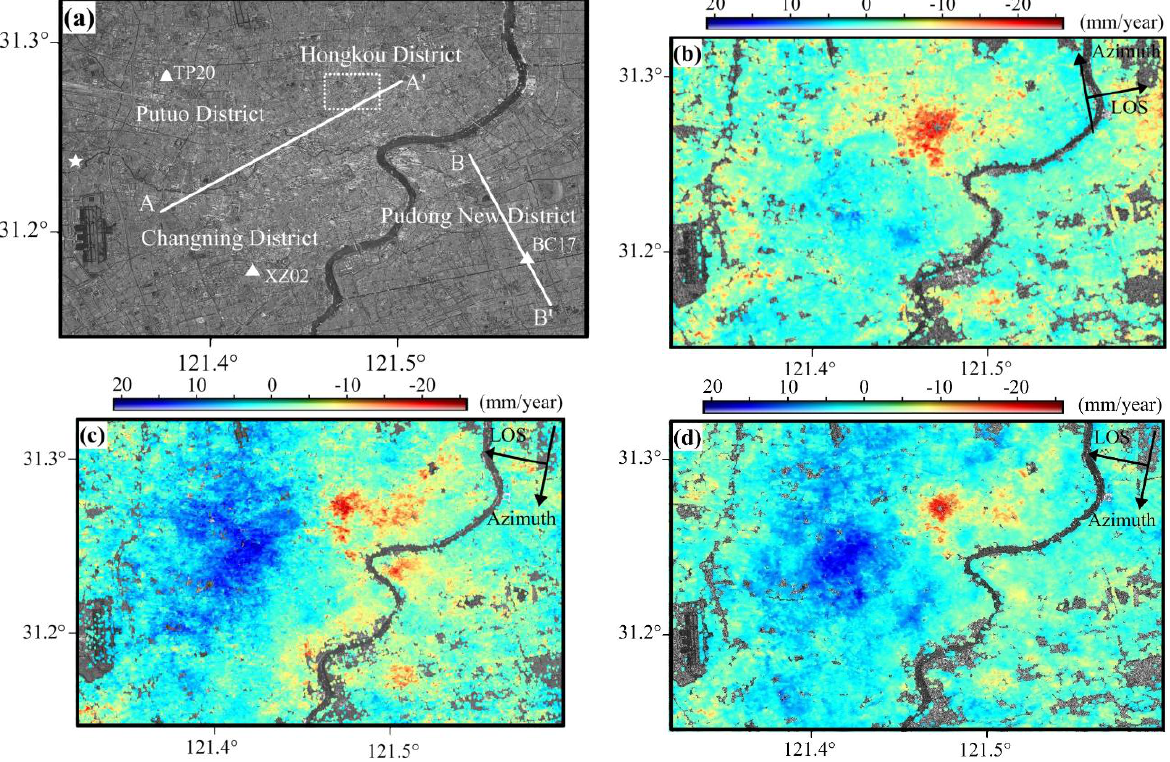
Figure 4. The SAR amplitude image and the VDRs in the study area derived through the TCPInSAR processing. ( a ) shows the SAR amplitude image with annotation of the placenames (Hongkou District, Pudong New District, Putuo District, and Changning District), three GPS sites (TP20, XZ20, and BC17), the reference point for interferometric processing (indicated by a white star), a dashed rectangle and two reference lines, which are used for later analysis. The VDRs are shown in ( b – d ) for the ascending CSK, descending CSK, and descending TSX case,